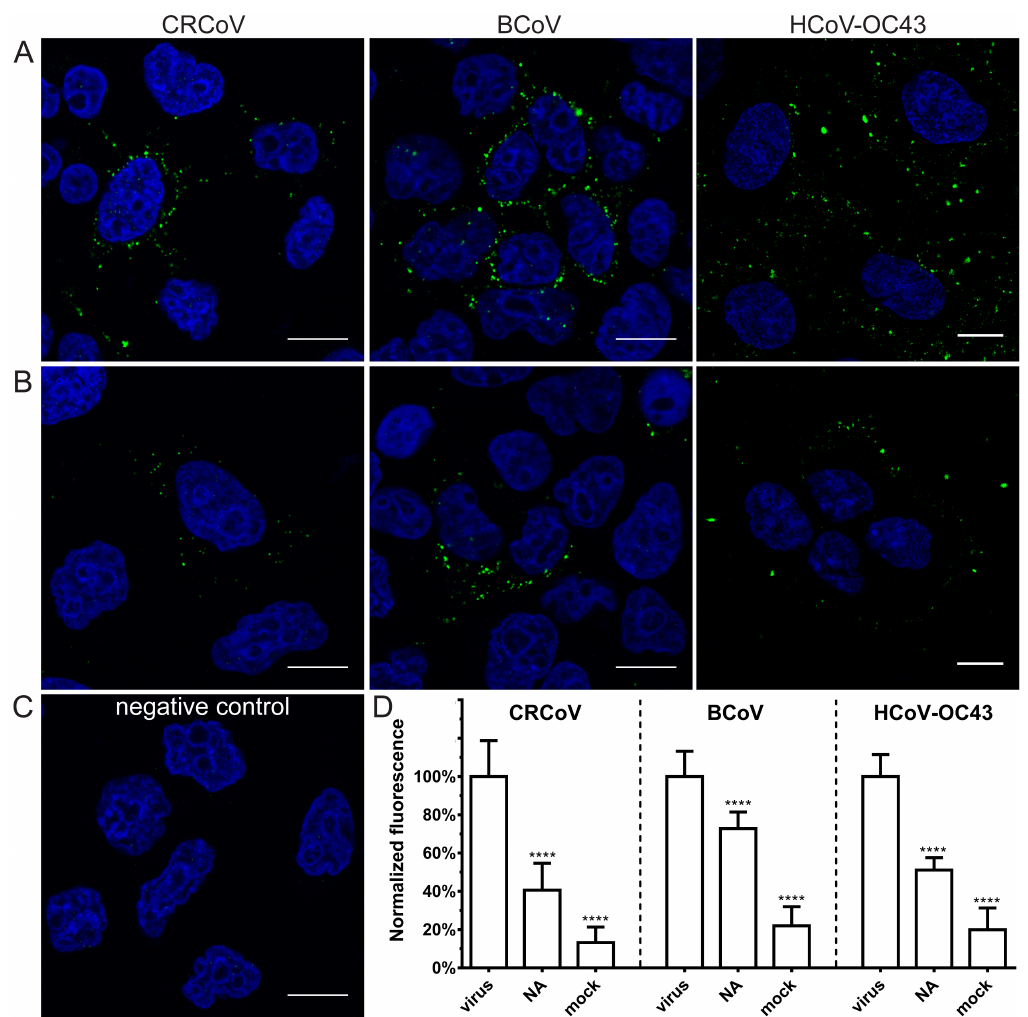
Figure 3. Removal of SAs from the surface of the cell limits attachment of HCoV-OC43 VR-1558, BCoV, and CRCoV to different extent. Cells pretreated with type II neuraminidase (NA, 200 mU/mL) were overlaid with HCoV-OC43, BCoV, and CRCoV stocks, incubated for 2 h at 4 ◦ C, fixed, and immunostained. Viral capsids are presented in green, while blue denotes DNA. Scale bar 10 µ m. Data were collected from a minimum of 12 fields of view, from at least three different samples. ( A ) virus inoculated, control cells; ( B ) virus inoculated, NA treated cells; ( C ) mock inoculated, non-treated cells; ( D ) FACS analysis of viral attachment in the presence of NA. Graph shows mean fluorescence normalized to control. The data is presented as mean ± SD from at least three experiments in triplicate. (* p < 0.05; ** p < 0.01; *** p < 0.001; **** p <